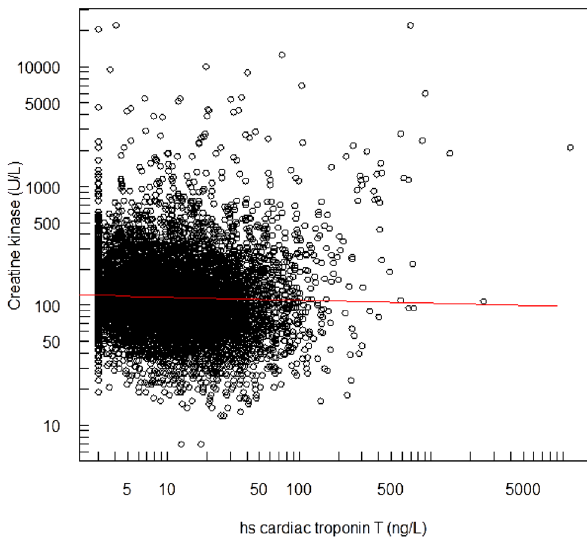
Figure 3: Creatine kinase activity and high sensitive cardiac troponin T (hs cardiac troponin) presented on a ln scale. The data were from male ambulant patients of a university hospital. Analysis for both hs-cTnT and creatinine were performed on the same sample. The red line is the regression function.